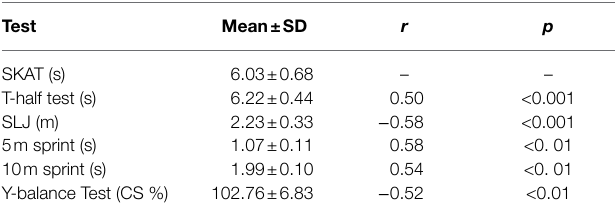
TABLE 3 | Means ± SD of athletes performances, correlation coefficient (r), and probability values of p between KCoDST and the CoD T-half-test